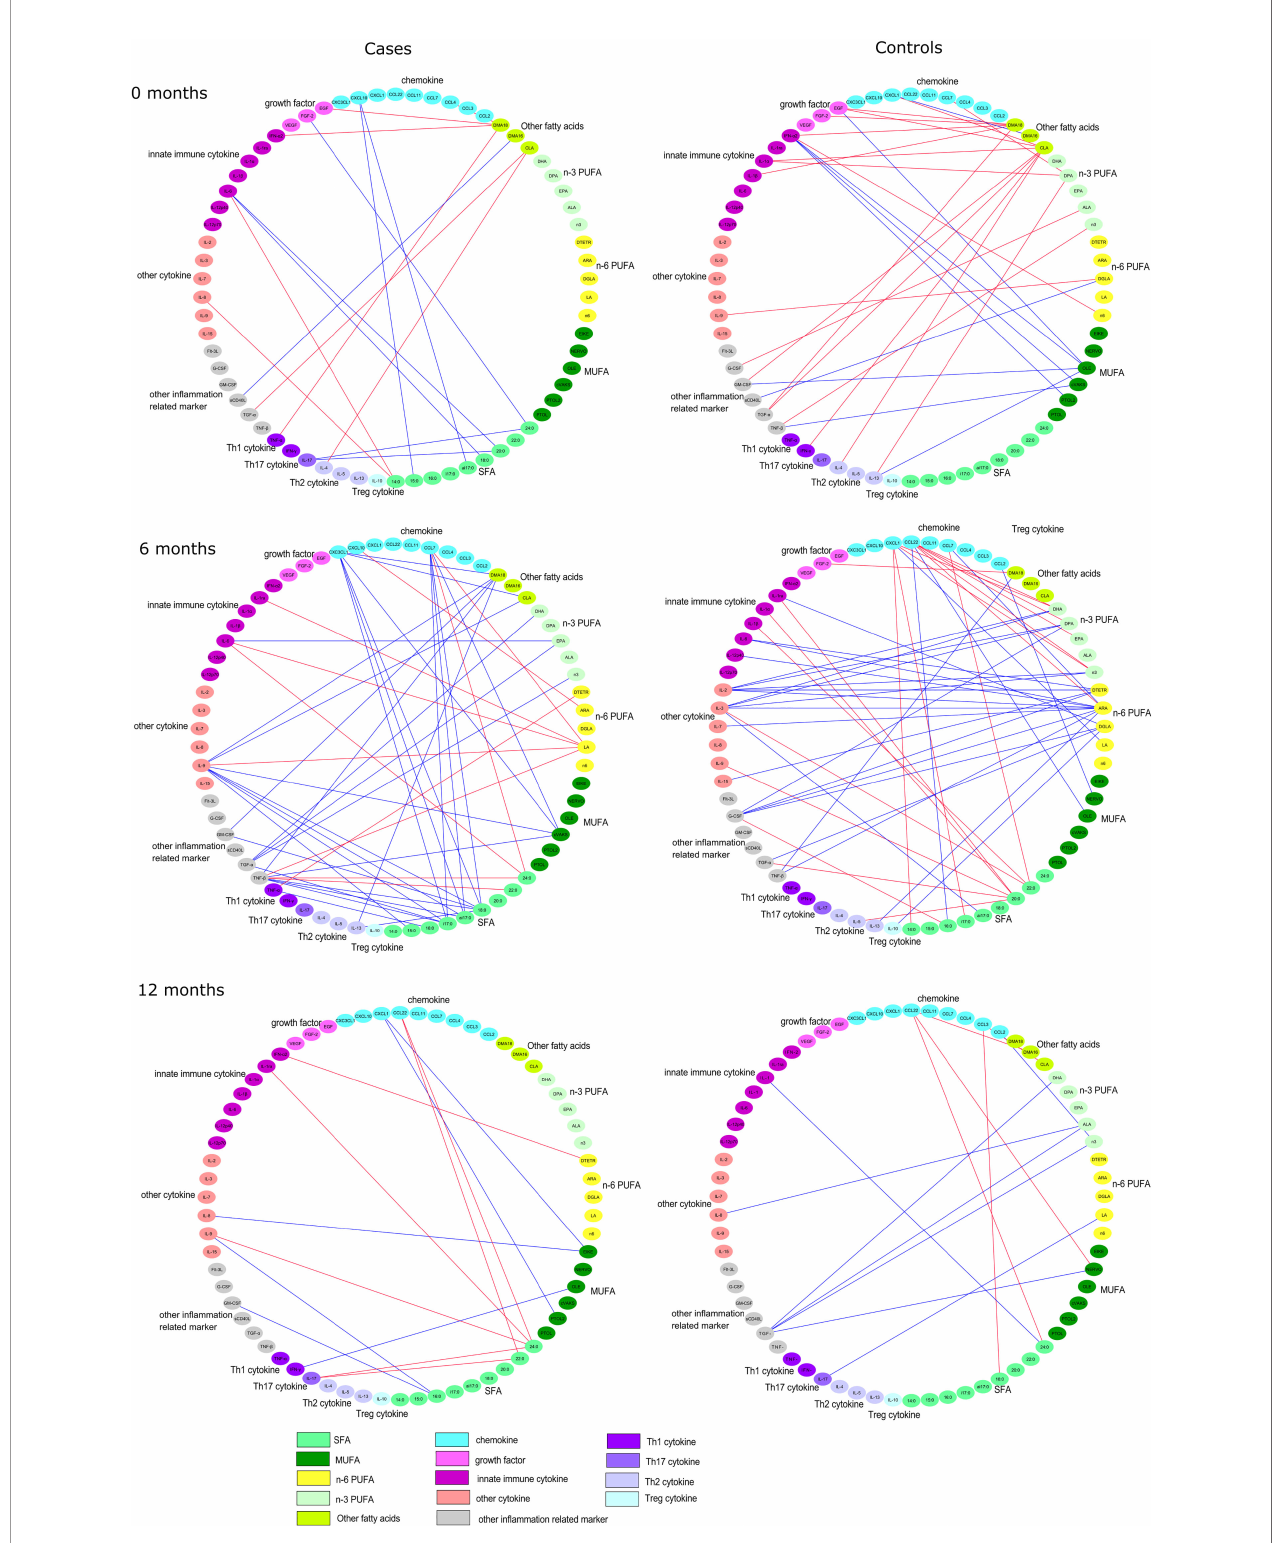
FIGURE 1 | Spearman correlation coef fi cients between serum fatty acids and immunological markers separately in case and in control children in cord serum, and at the ages of 6 and 12 months. All the direct correlations are marked with red edges, while the inverse correlations are marked with blue edges with a cutoff of p <